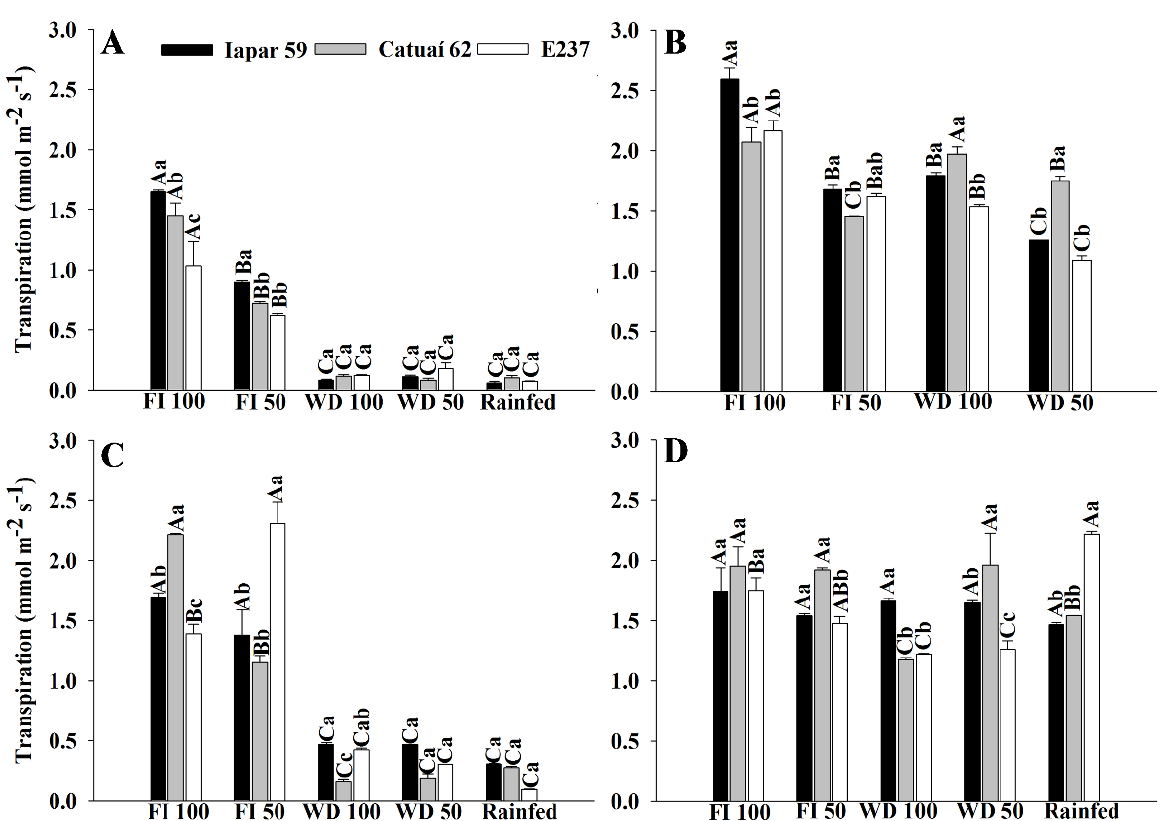
Figure 5. Transpiration of coffee leaves under water stress ( A , C ) and after irrigation ( B , D ), in 2019 ( A , B ) and 2020 ( C , D ), of three arabica coffee genotypes (Iapar 59, Catuaí 62 and E237) under five water regimes (FI 100, FI 50, WD 100, WD 50 and rainfed). Capital letters compare the water regimes for each cultivar and lowercase letters compare the cultivars of each water regime. Means followed by the same letter do not differ according to the Tukey test at 5% probability. FI 100 and 50 (full irrigation with 100% and 50% replacement of evapotranspiration); WD 100 and 50 (water deficit with the suspension of irrigation from June to September, with replacement of 100% and 50% of evapotranspiration, respectively); rainfed (without irrigation). Table 2. Effect of water regimes (FI 100%, FI 50%, WD 100%, WD 50% and rainfed) in terms of relative water content (RWC) in leaves of coffee arabica genotypes after the return of irrigation,